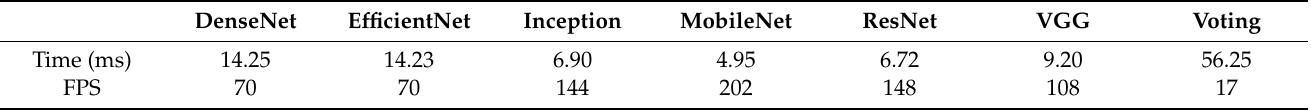
Table 9. Elapsed time for classifying one image using the soft voting ensemble (CPU only).